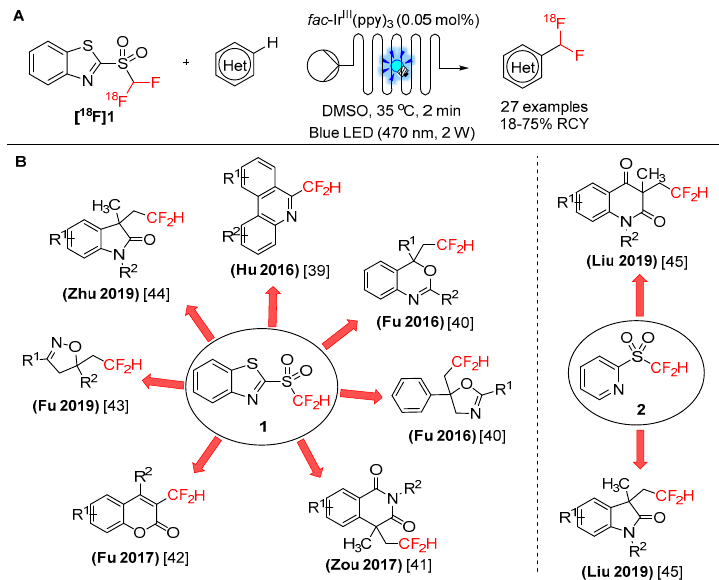
Figure 1. ( A ) Photoredox C–H 18 F-difluoromethylation of N -containing heteroarenes with Figure 1. ( A )PhotoredoxC–H 18 F-difluoromethylationof N -containingheteroareneswith[ 18